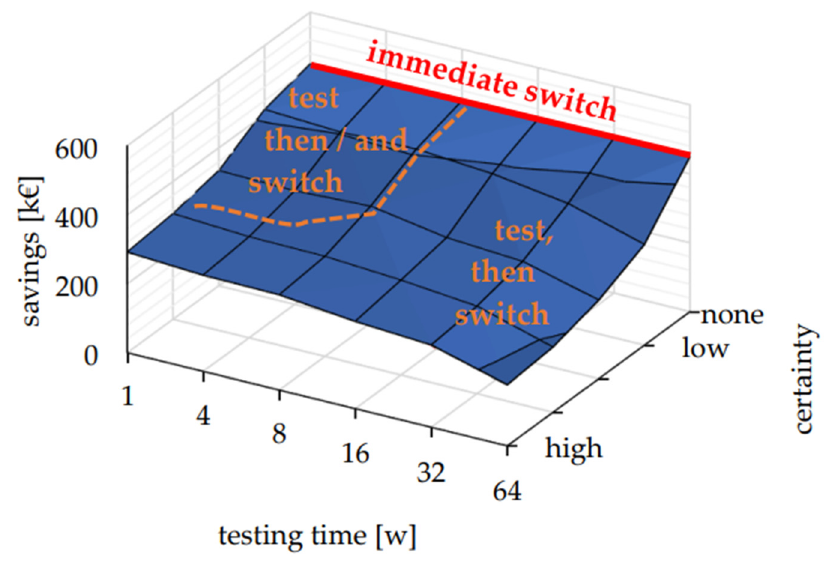
Figure 7. Dependency of the expected saving, testing time and certainty about the specification and performance of the